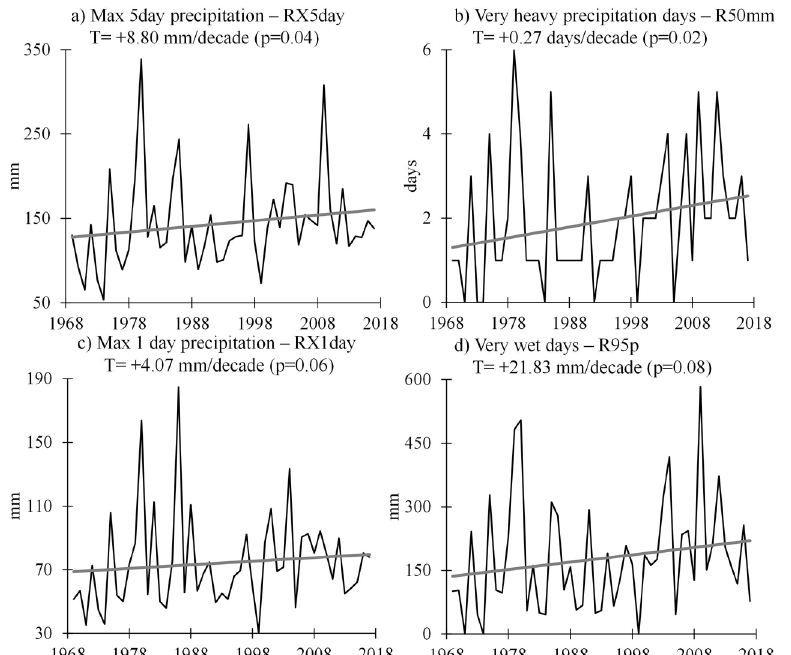
Figure 6. Temporal distribution of the extreme precipitation indices in the 1968–2017 period for summer (DJF = December, January and February). Index with gray line indicates significant linear trend (Table III), T indicates magnitude of trend, and p stands statistical